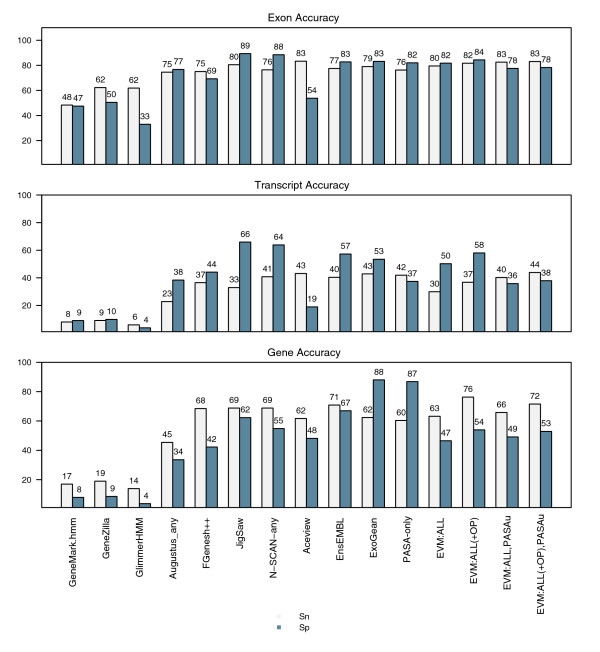
EVM and PASA automated annotation accuracies compared to alternatives. The gene prediction accuracy of both EVidenceModeler (EVM) and Program to Assemble Spliced Alignments (PASA) are shown in the context of the other methods evaluated as part of the ENCODE Genome Annotation Assessment Project (EGASP) competition. Although PASA alone performs quite well, the benefits from applying PASA as a postprocess to the EVM consensus predictions are not immediately apparent, except in the enumeration of alternatively spliced isoforms as shown in Figure 10. PASA and EVM are shown to perform similarly to the best performing methods in the EGASP competition.